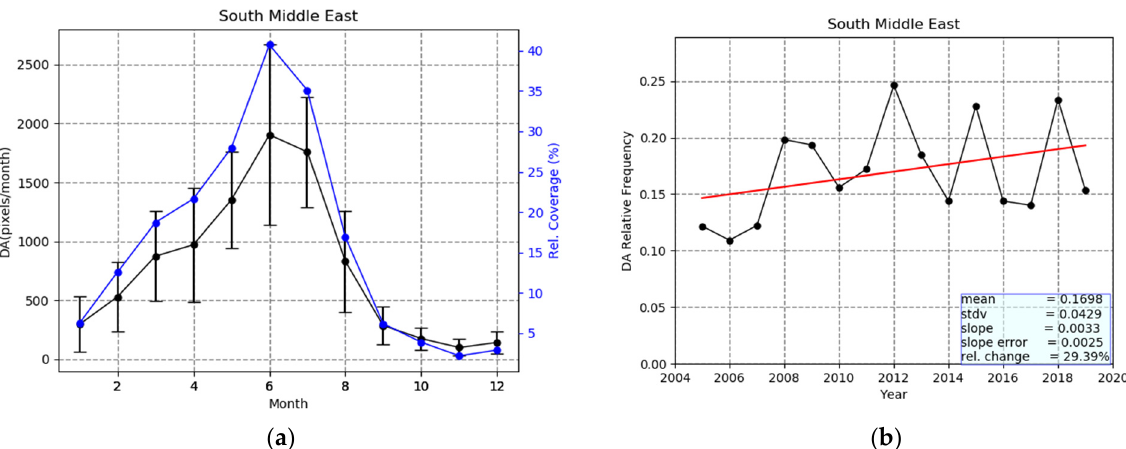
Figure 17. ( a ) Intra-annual variability of the 2005–2019 averages of the total absolute number of grid cells (1° × 1°) where dust aerosols (DA) were detected over South Middle East by the satellite algorithm (left axis) and the percent coverage of the region by dusty grid cells (right axis). The error bars represent the year-by-year variability by means of computed 2005–2019 standard deviations. ( b ) Inter-annual variability and linear trend of the relative frequency of dust aerosols (DA) over South Middle East.